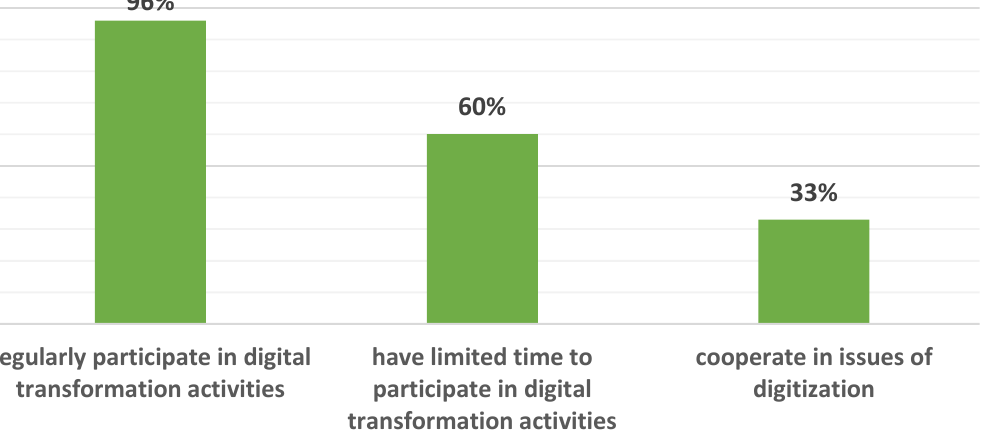
Figure 1: Results of VS principals’ survey on teachers’ use of digital technologies at lessons (based on